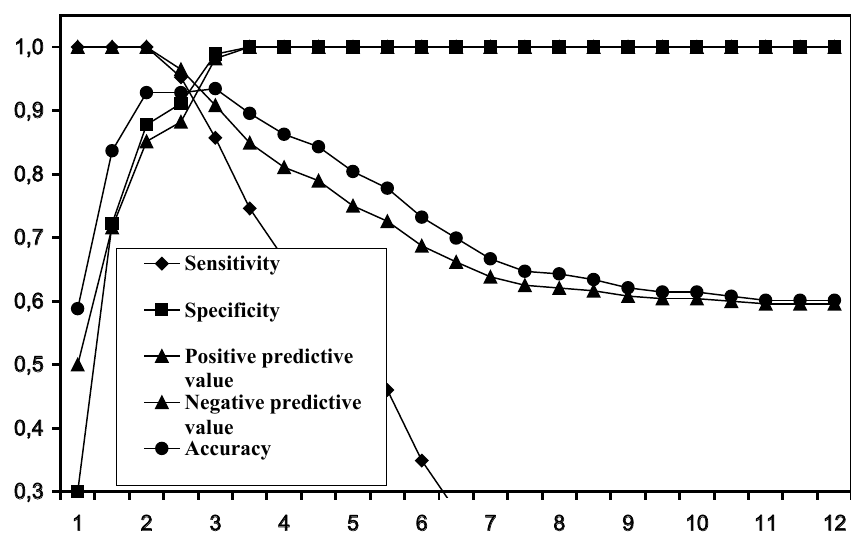
Fig. 3. Ratio of peak systolic velocities in the internal and common carotid artery.